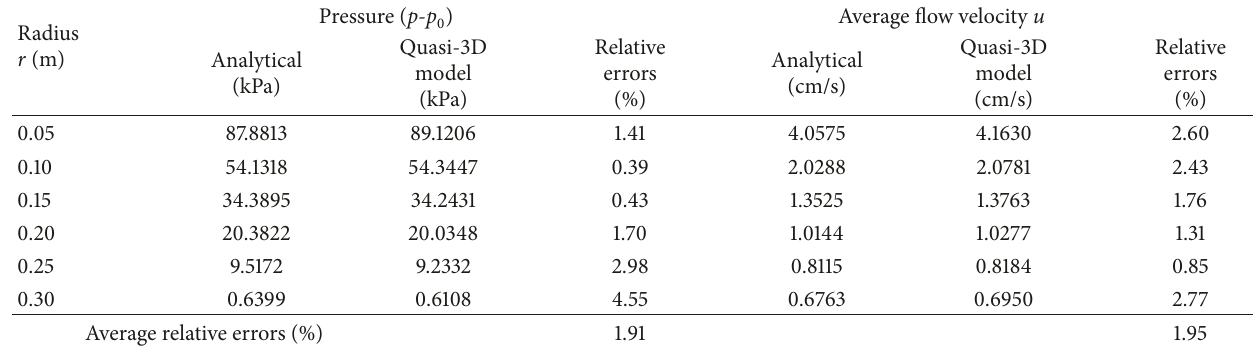
Table 8: Distribution of the pressure and average flow velocity over the radius at t = 20 s in Case 2.